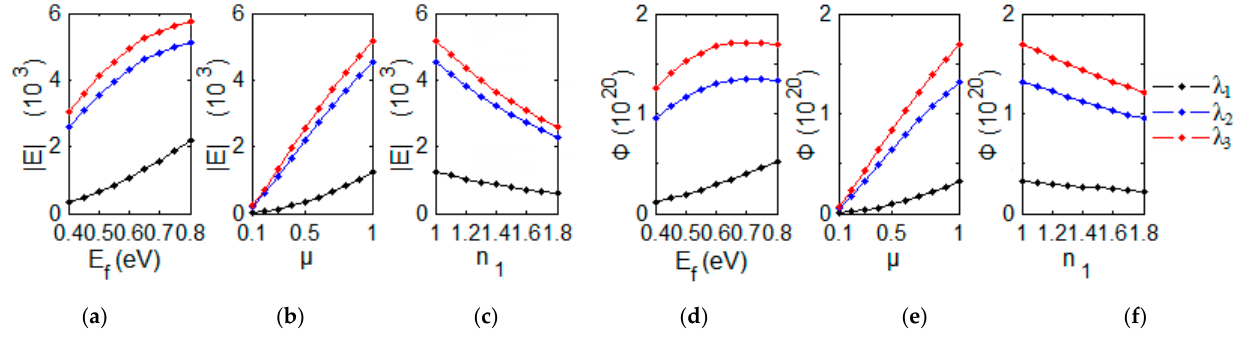
Figure 2. The amplitude of electric field (|E|) with different ( a ) E f , ( b ) μ , ( c ) n 1 , and photon flux density Φ with different ( d ) E f , ( e ) μ , ( f ) n 1 at resonant wavelengths λ 1 , λ 2 and λ 3 inside the graphene region with FDTD simulation, respectively.